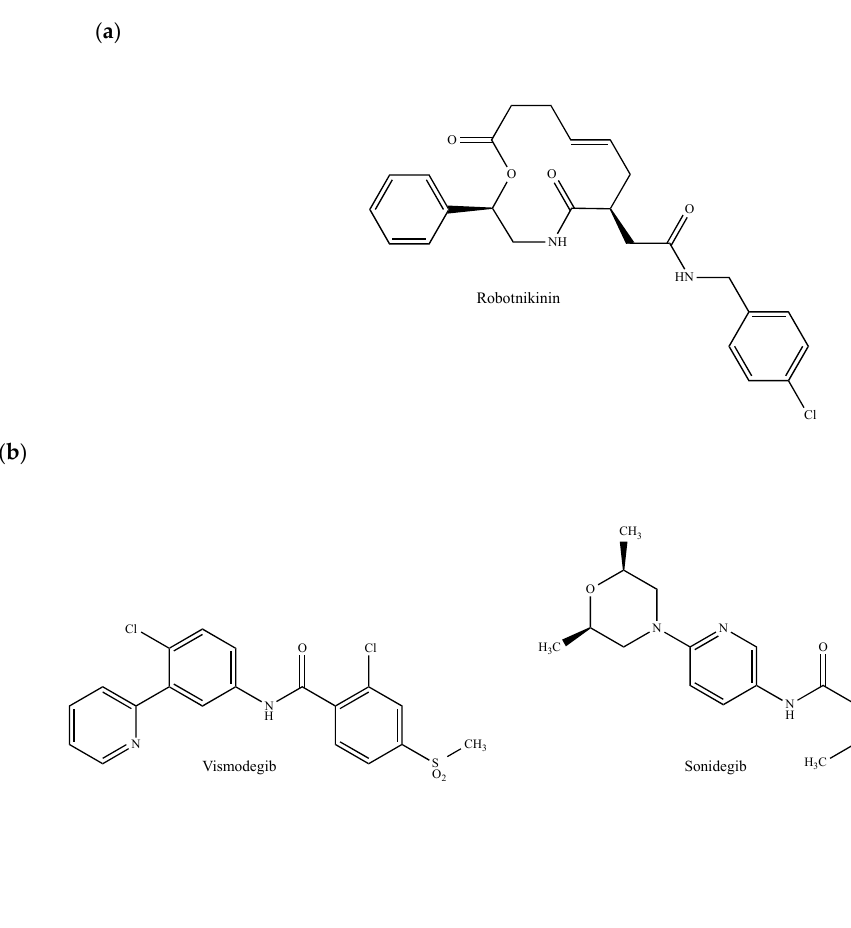
(sequence: N–Formyl–Met–Asp–Gly–Cys–Glu–Leu–COOH) causes a significant reduction of breast tumor metastases in immunodeficient and immunocompetent mice [272]. Finally, a monoclonal antibody to FZD receptors (OMP-18R5, Vantictumab ® ) was shown to block the canonical Wnt pathway and to suppress breast cancer cell growth in a human tumor xenograft [273].